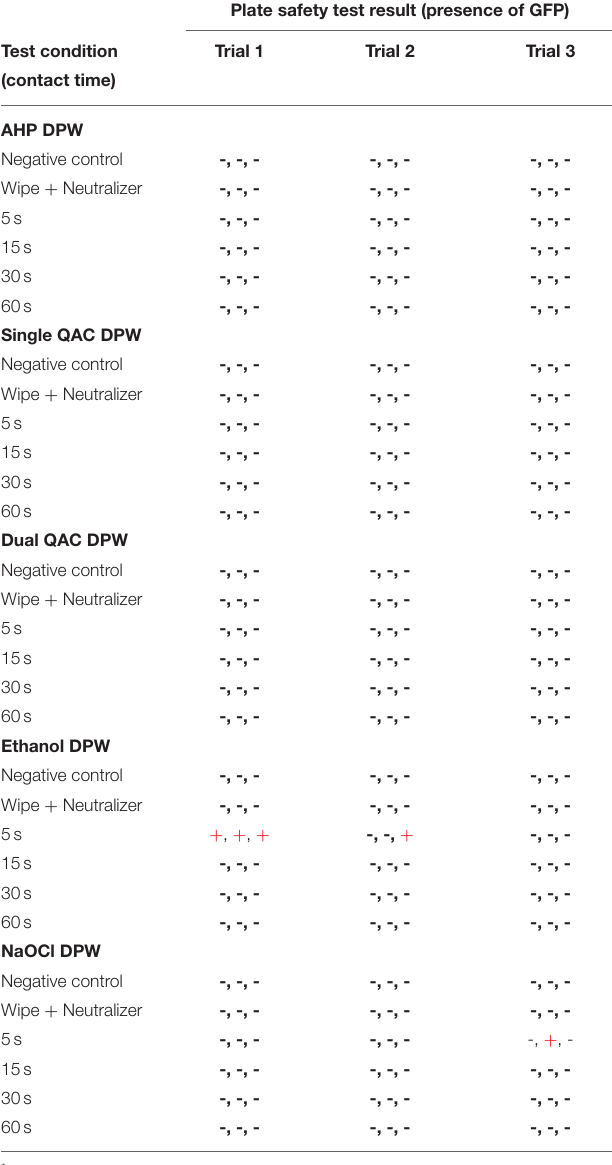
TABLE 4 | Plate safety test results for the inactivation of VSV by DPW vs. DMEM-impregnated J-Cloth wipes *